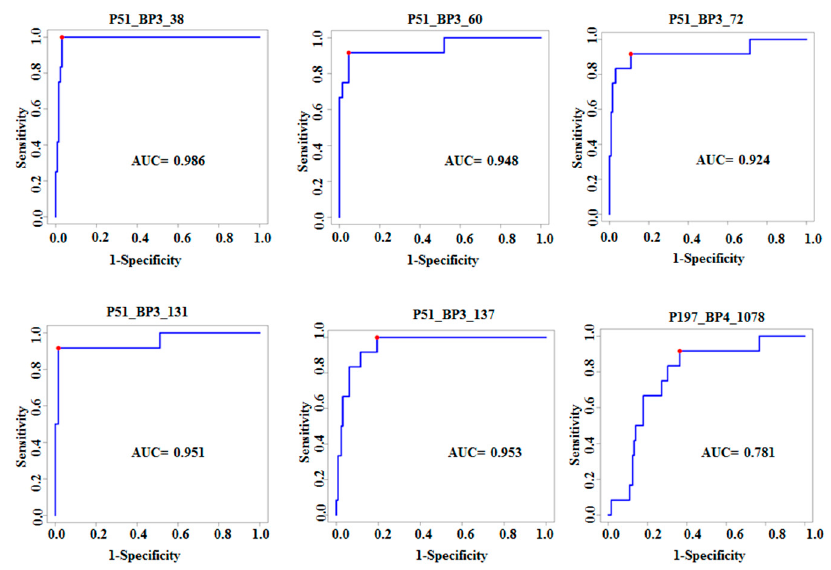
Figure 4. ROCs for top 6 significant clones that are increased in TB sera compared to healthy controls and sarcoidosis.